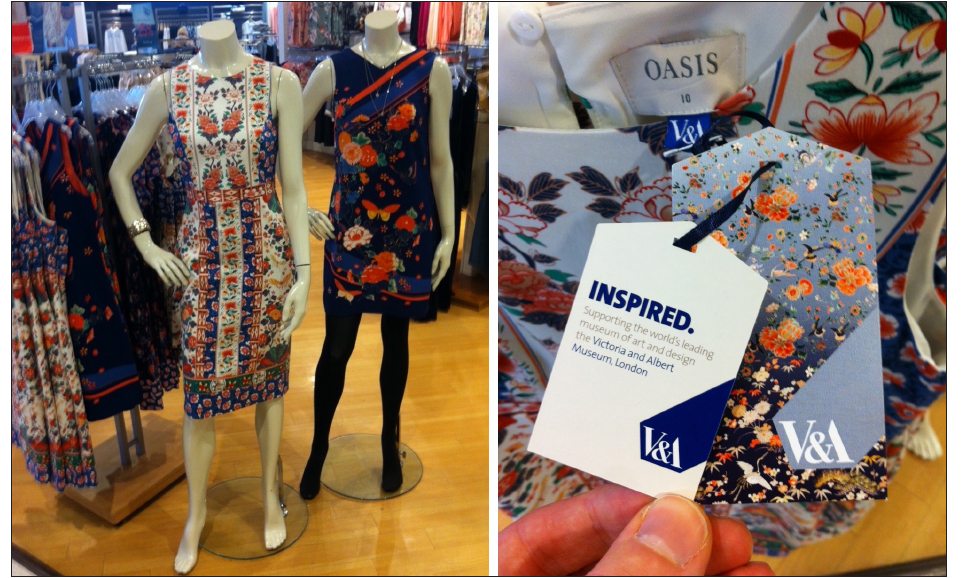
Figure 3: Oasis dresses inspired by V&A prints (and sales tags) on sale at Binns department store, Middlesbrough. (Photo